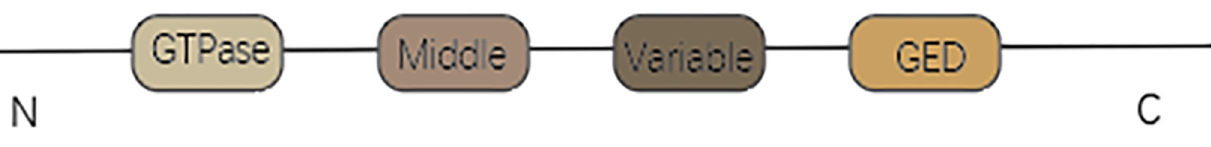
Figure 6. Schematic diagram of the DRP1 structure. GTPase: highly conserved N-terminal GTPase domain. Middle: helical middle domain. Variable: variable domain (also known as insert B). GED: a C-terminal GTPase effector domain.